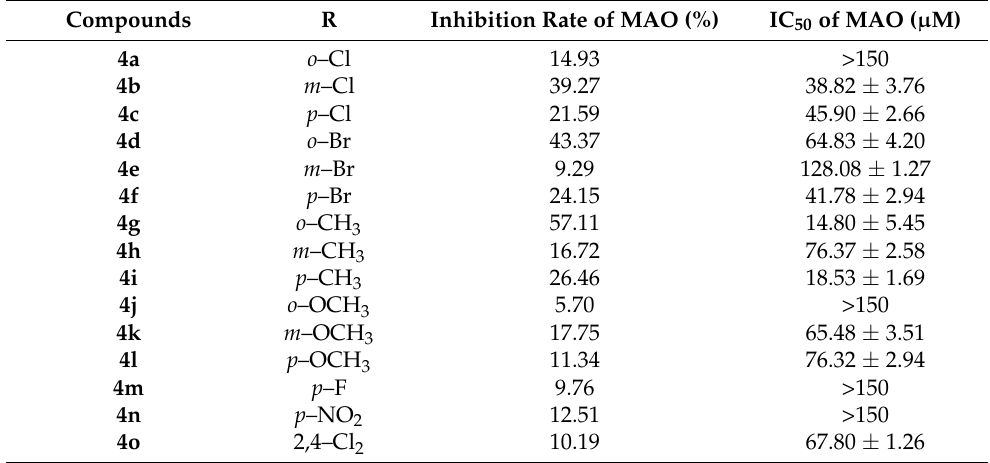
Table 1. Test results of inhibitory activity of benzothiazole–isoquinoline derivatives 4a – 4p on MAO.